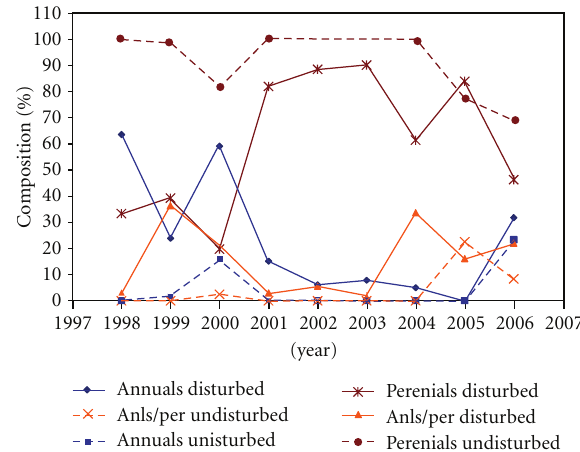
Figure 5: Composition of annuals and perennial grass species in disturbed (distbd) and undisturbed (undistbd) sites in CKGR:1998 to